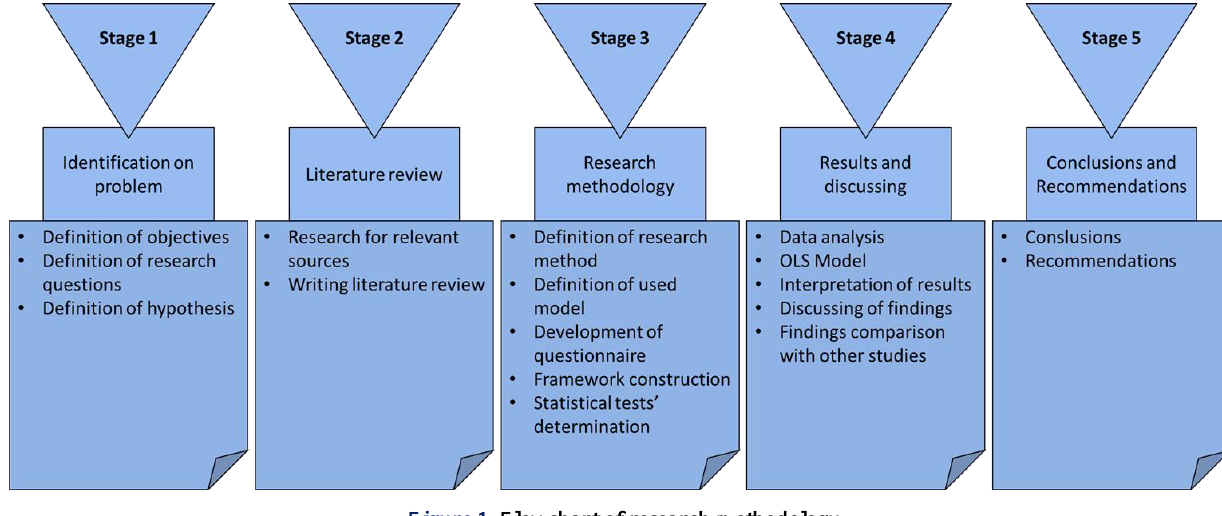
Figure 1. Flowchart of research methodology